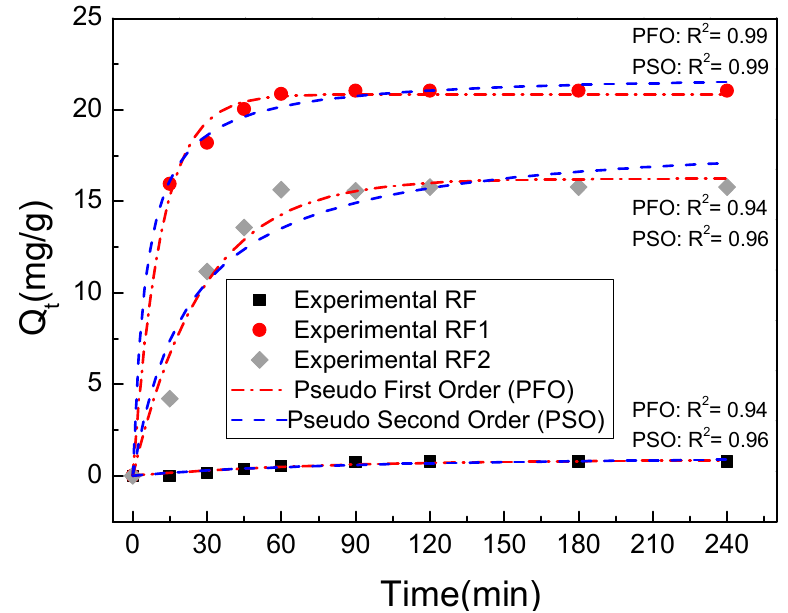
Figure 8. Kinetic graph of MO in room temperature conditions, adsorbent mass 100 mg, fixating (C i ) in 50 mg/L. Materials 2020 , 13 , x FOR PEER REVIEW